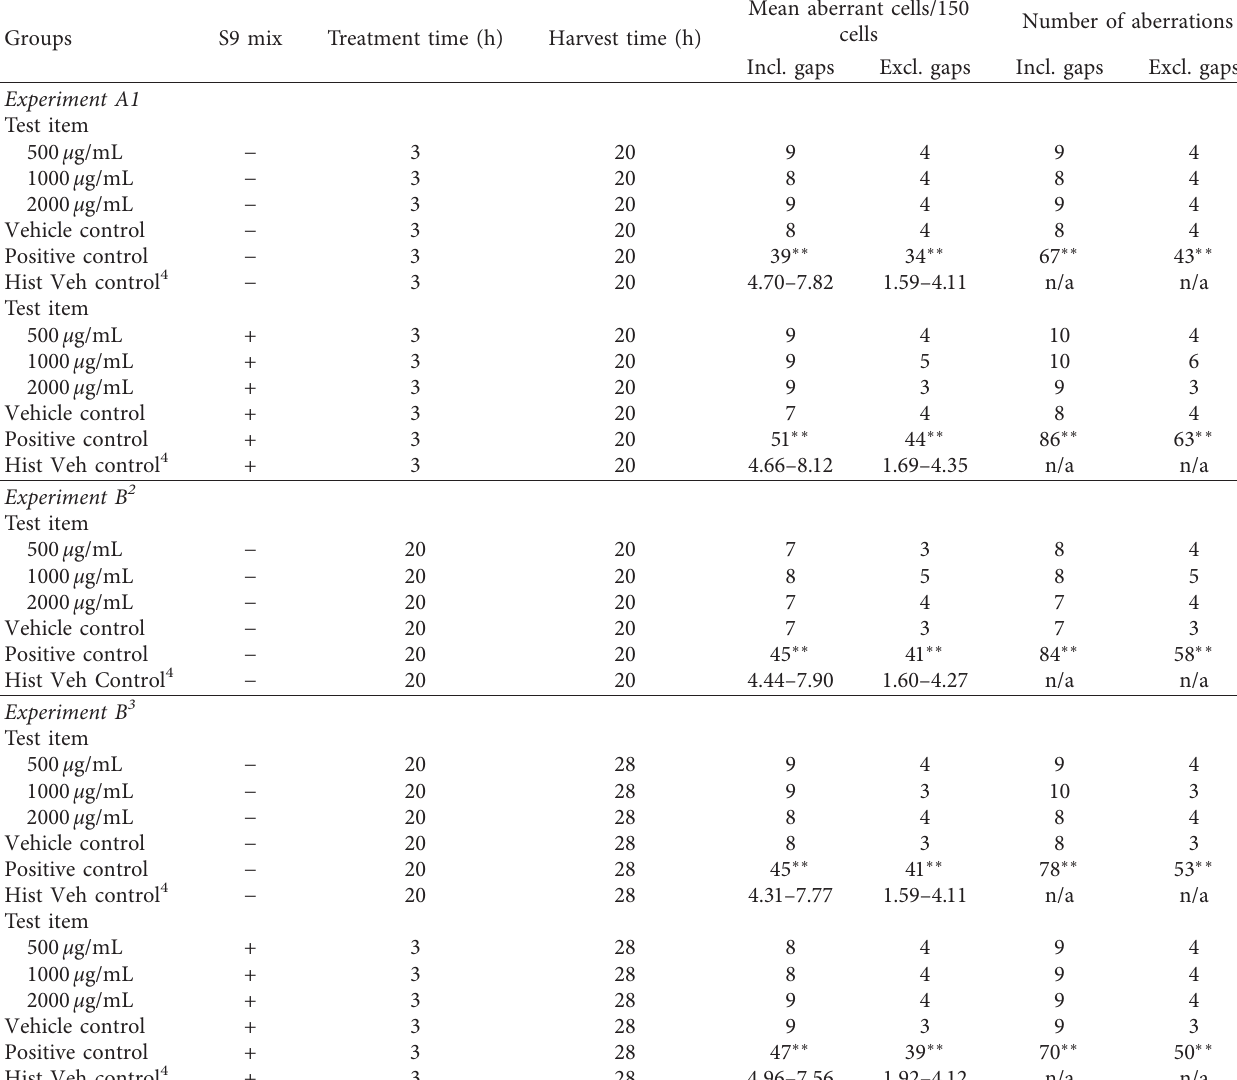
Table 3: Summary of chromosomal aberration test results.